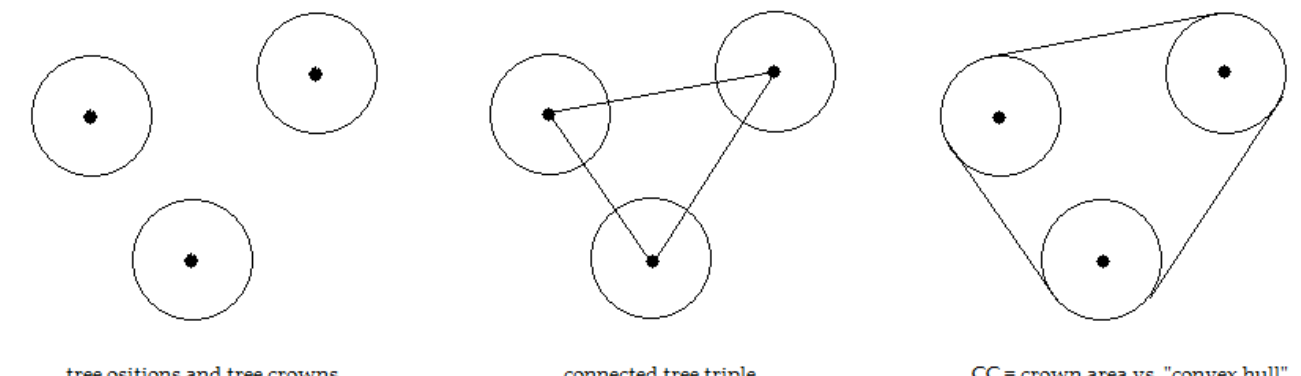
Figure 3. Area for which the percentage cover is calculated: Method 1 [50–53].